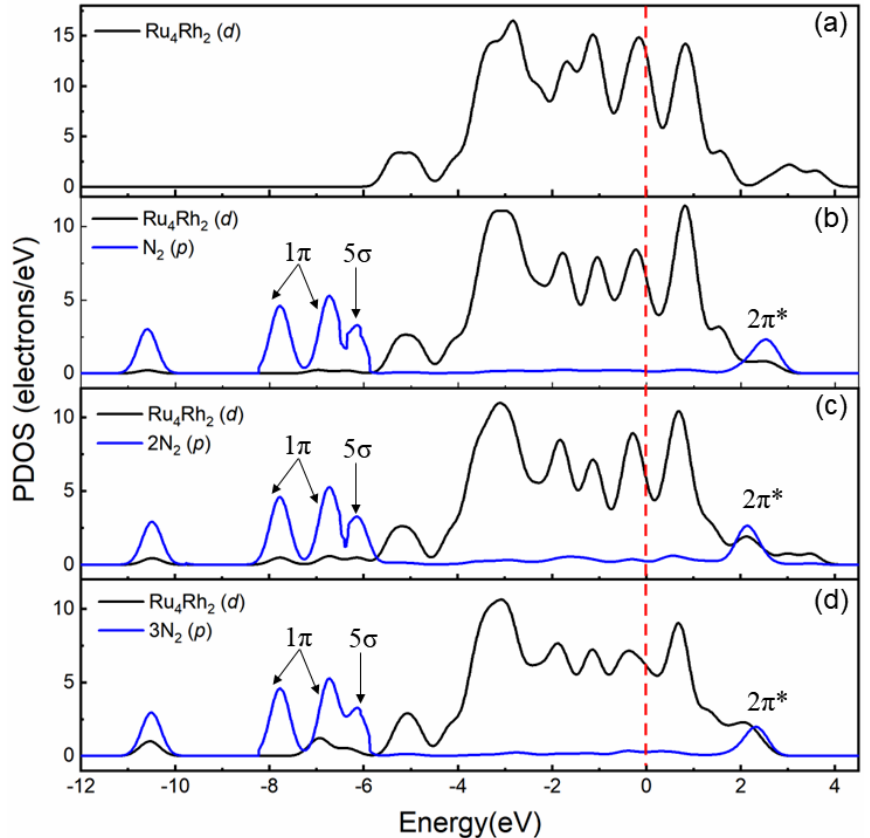
Figure 8. Partial density of states (PDOS) on the N 2 molecule ( p orbital) (blue line) adsorbed on the Ru 4 Rh 2 cluster ( d orbital) (black line) under conditions: ( a ) Without adsorbed, ( b ) N 2 adsorbed, ( c ) two N 2 and ( d ) three N 2 co-adsorbed, respectively, where 1 π and 5 σ represent the bonding orbitals, and 2 π * represents the antibonding orbitals of N 2 molecules. The Fermi level was shifted to 0 eV. The plot shows that the hybridization between p orbital of N 2 and d orbital of Ru 4 Rh 2 cluster becomes increasingly strong with the increase in the number of N 2 adsorption.